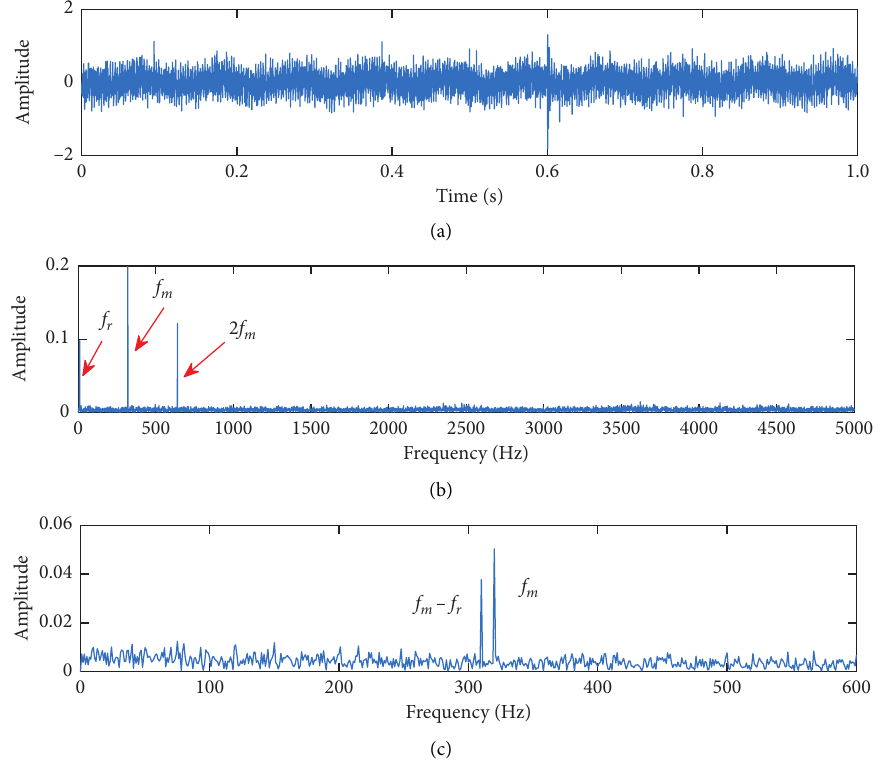
Figure 11: Simulated signals of case 2: (a) time-domain waveform, (b) frequency spectrum, and (c) squared envelope